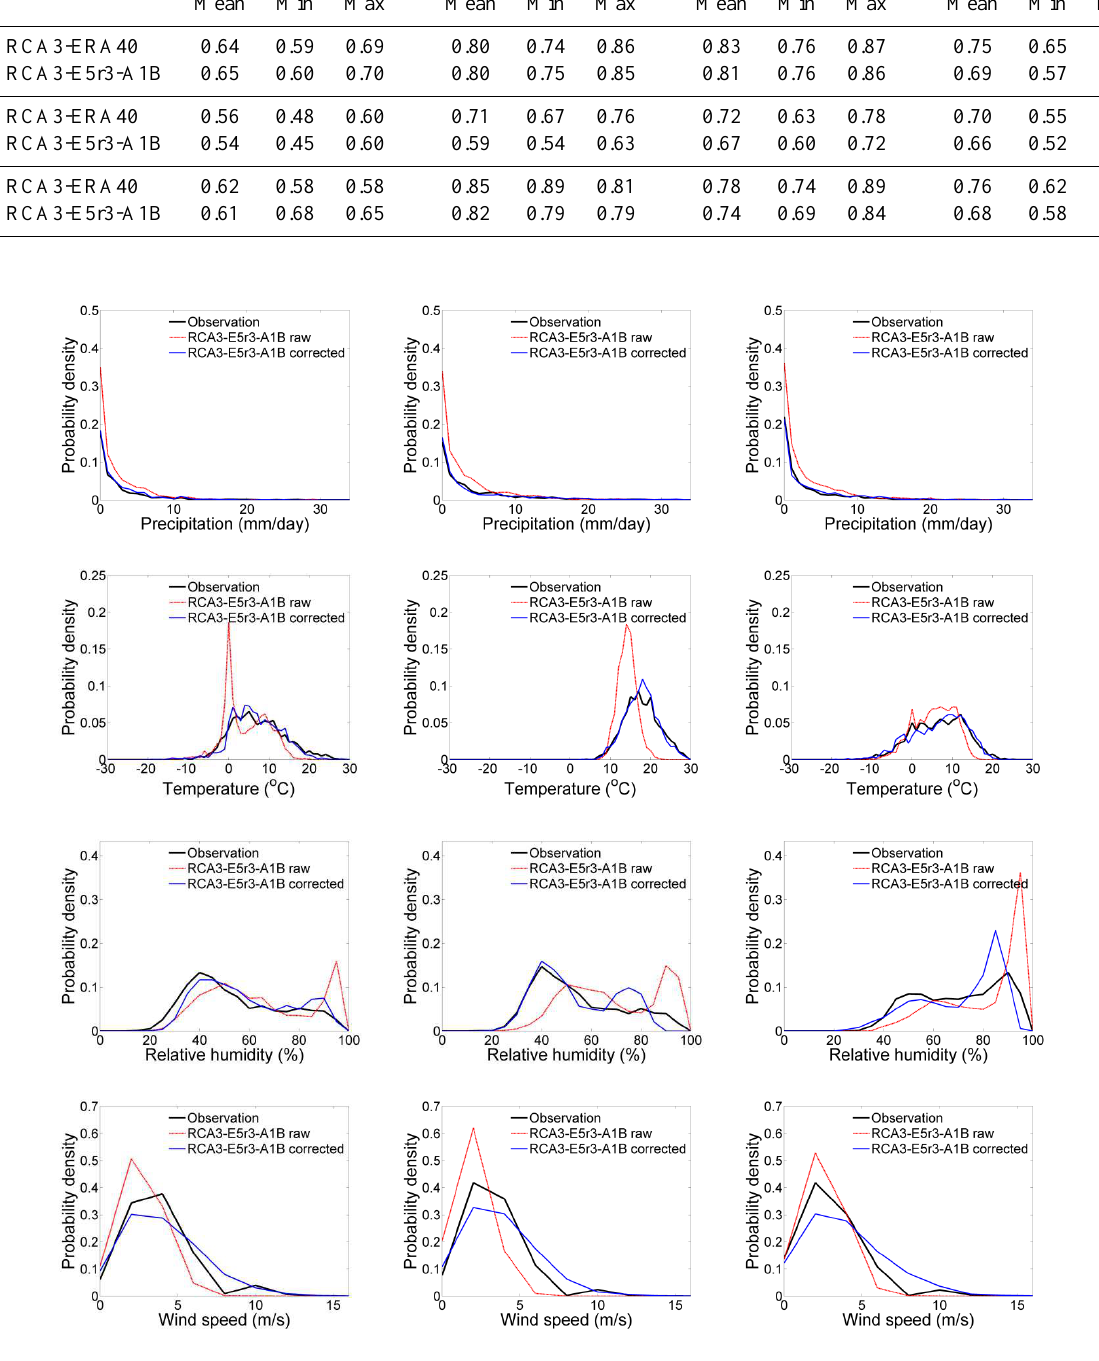
Figure 5. Probability density functions of precipitation, temperature, relative humidity and wind speed at the Edsbyn station (see Fig. 1). Comparison of observational data, the raw output of the climate model, RCA3-E5r3-A1B, and its corresponding adjusted output (validation period